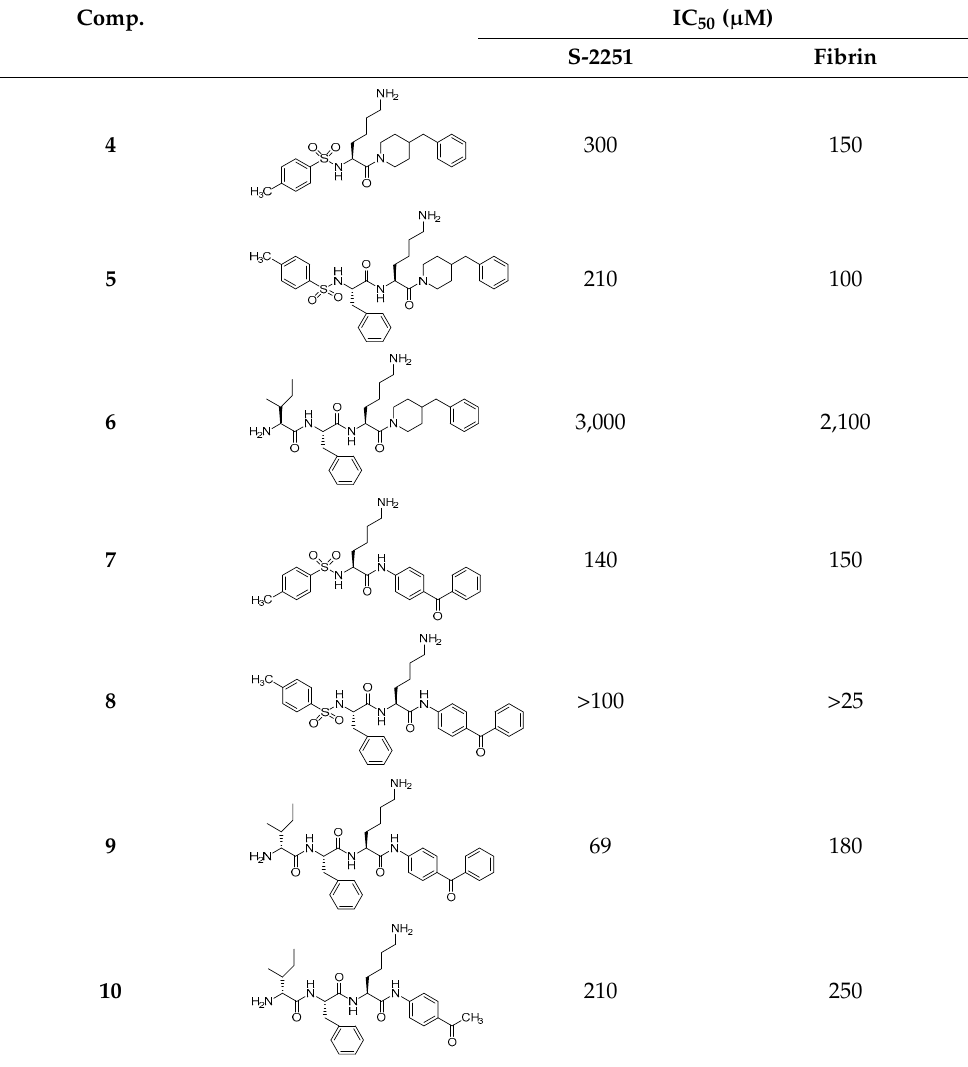
Table 2. Plm inhibitory activity of compounds 4 – 10 [28]. Comp.